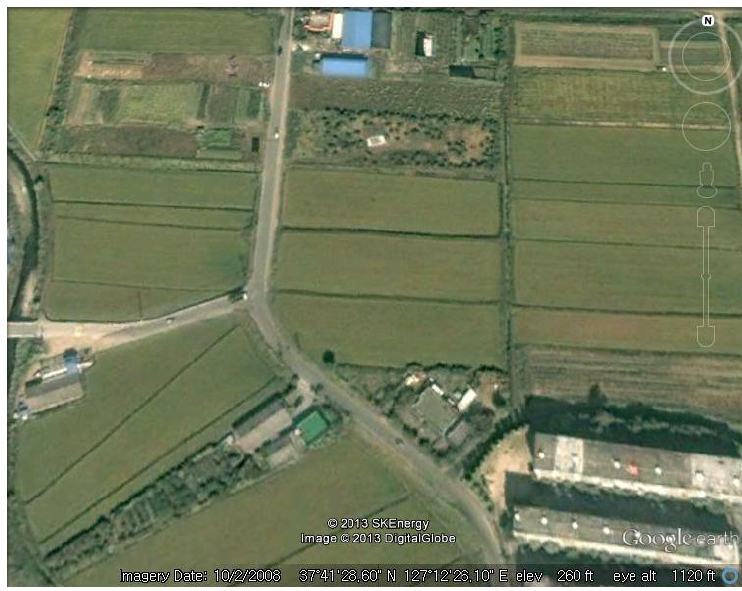
Figure 1. A satellite view of Cx. p. pallens larvae collection site & venue for semi-field